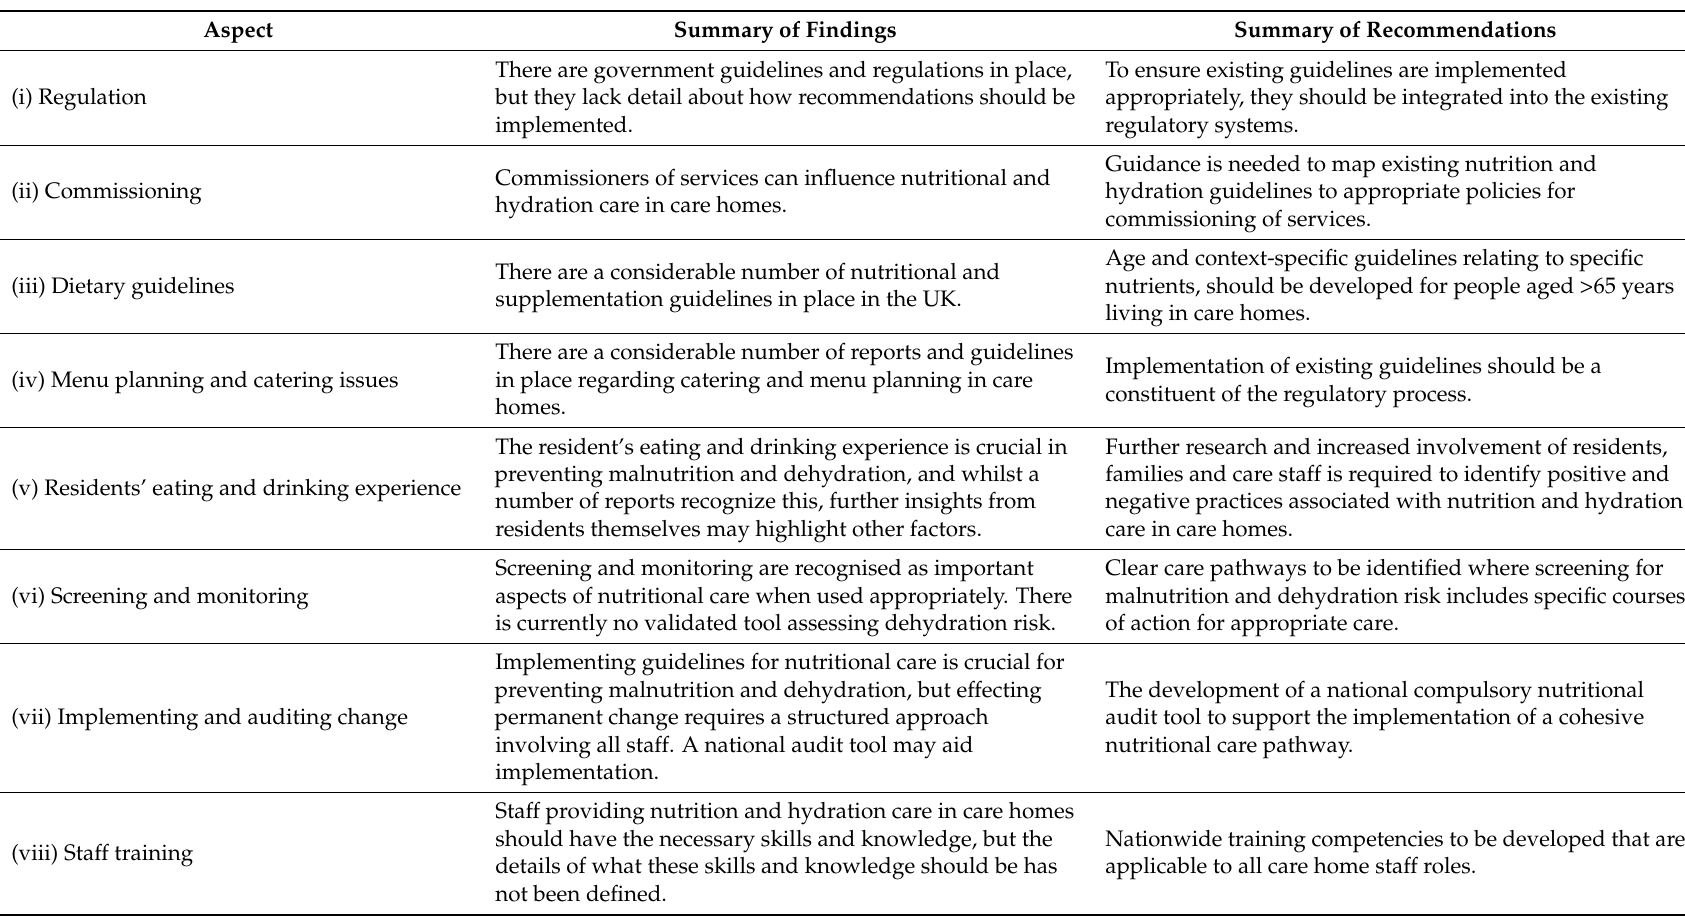
Table 1. Key aspects of nutritional and hydration care in care